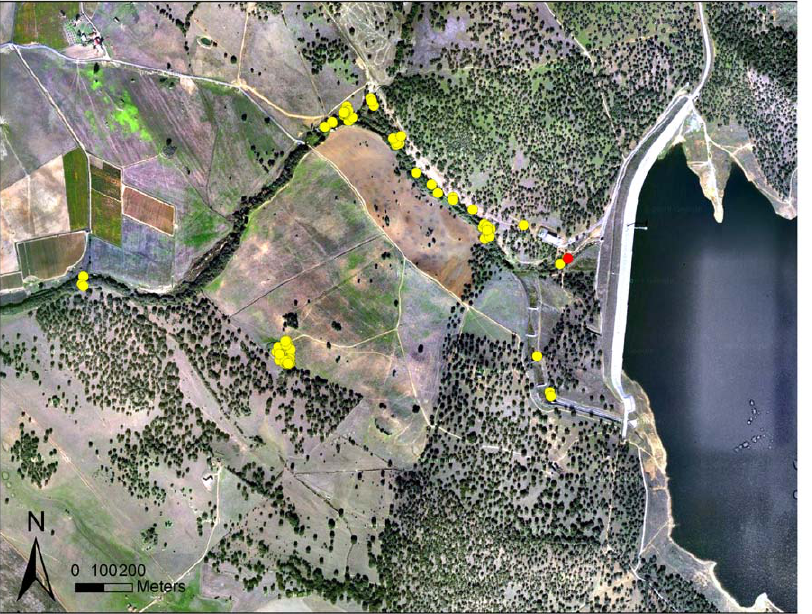
Figure 1. Locations of a wild-free-ranging otter accessed on the Internet in real time. They concerns the GPS harness (H3) (male otter) and are projected on a Google map. Yellow points represent each location; the red point is the capture (and release)